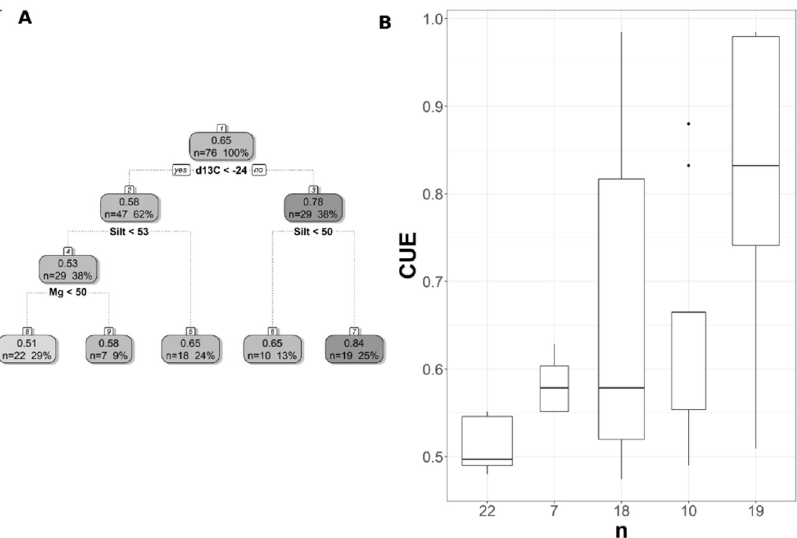
Figure 7. Pruned regression tree for ( A ) MODIS CUE predicted as a function of two significant var- iables The number in boxes 1 and 3 represent the mean CUE of the node, n value represents the terminal node size, soil variables names under the boxes represent the splitting criterion, and the numbers in boxes 2, 6, and 7 represent the mean estimated CUE. Note that the position of “yes” and “no” at each split represents the decision split at each node. ( B ) Boxplots showing the distribution of CUE in each terminal branch in the regression tree. The model has r 2 of 0.78 and MAE of 0.06.